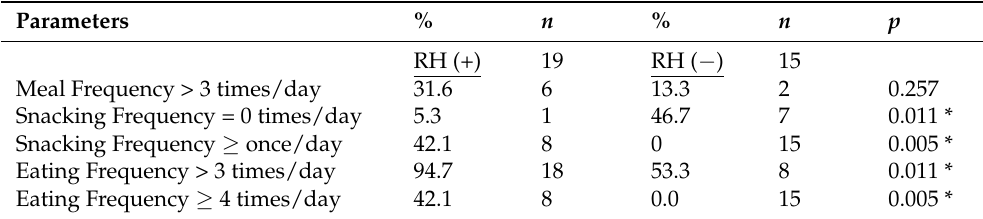
Table 4. Proportions of the eating behavior categories in subjects with and without react- ive